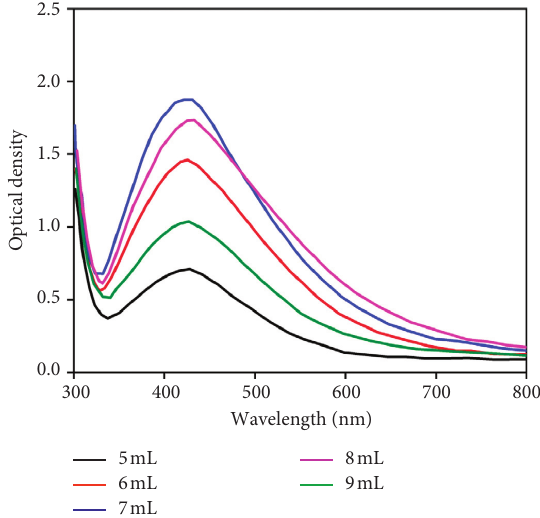
Figure 5: UV-vis absorption spectra of silver nanoparticles recorded as a function of 0.01M AgNO 3 solution with different extract volumes. Reaction temperature: 50 ° C; reaction time: 120 min.